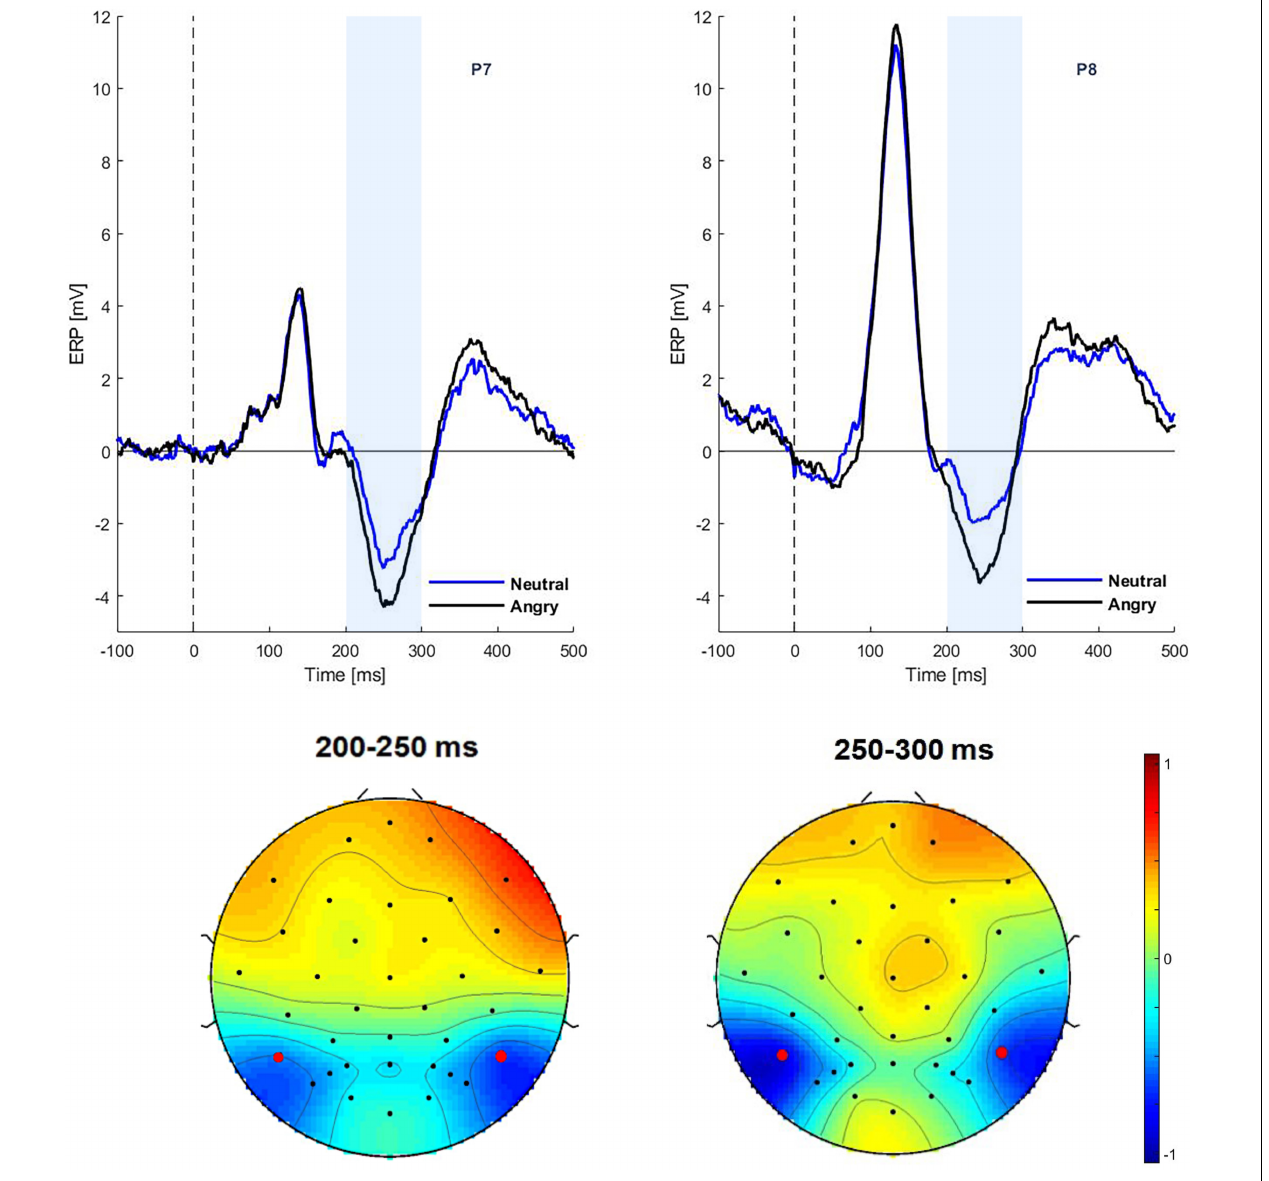
FIGURE 2 | Grand average ERPs in the START interval. Top : ERPs at electrodes P7 and P8 for neutral and angry expressions. Bottom : Scalp topographies of the emotion effect (angry minus neutral) for the time window of 200–250 and 250–300